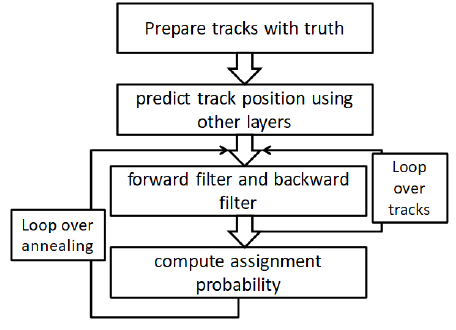
Fig. 2. Flow chart of fitting multi-turn track candidates